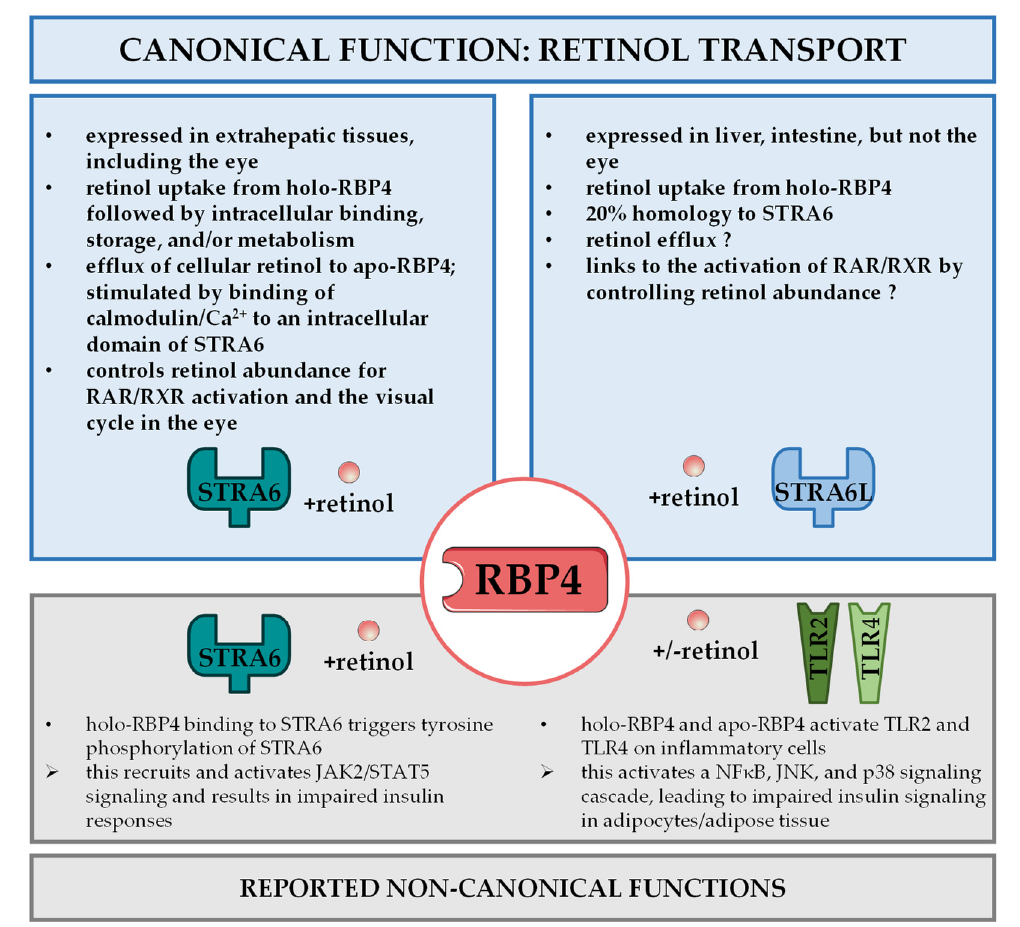
Figure 2. RBP4 receptor interactions. Distinct receptor proteins mediate canonical and non-canonical functions of RBP4. ‘Stimulated by retinoic acid 6’ (STRA6) in extrahepatic tissues and ‘stimulated by retinoic acid 6 like’ (STRA6L, also known as RBPR2) in liver and intestine are involved in retinol uptake and its coupling to RAR/RXR signaling in target cells and the visual cycle in the eye, referred to as canonical functions of RBP4 (top panel). STRA6 was also reported to activate janus kinase 2 (JAK2)/signal transducer and activator of transcription 5 (STAT5) signaling to impair insulin signaling. RBP4 recognition by Toll-like receptors 2 and 4 (TLR2/TLR4) was shown to induce a signaling cascade involving nuclear factor κ B (NF κ B), c-jun N-terminal kinases (JNK), and p38 that impedes on insulin sensitivity. Both mechanisms are designated as non-canonical functions of retinol (bottom panel).